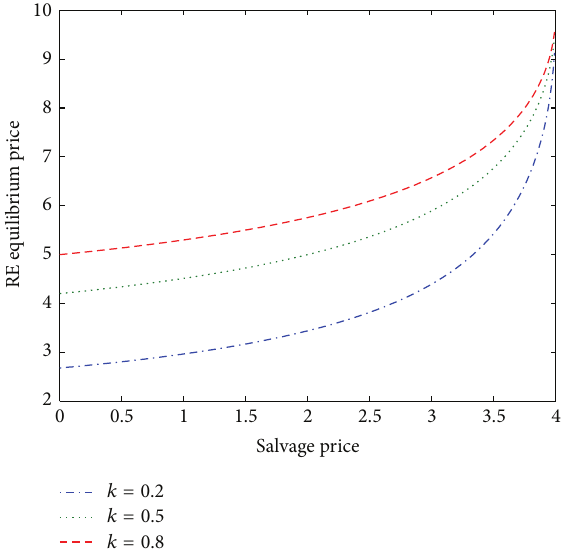
Figure 3: The effect of salvage price on 𝑝